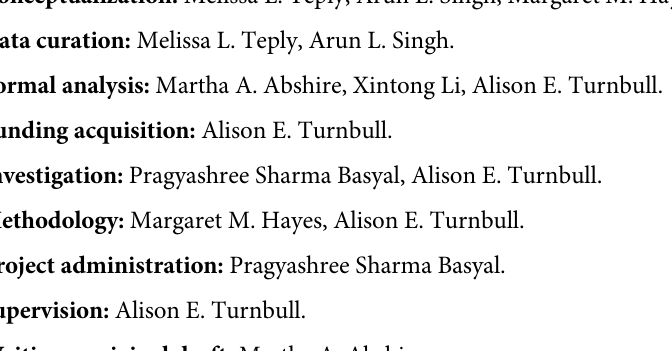
S2 Table. Example of written QA review including dialogue, errors and feedback. S1 Fig. Distribution of total errors and major errors by standardized family